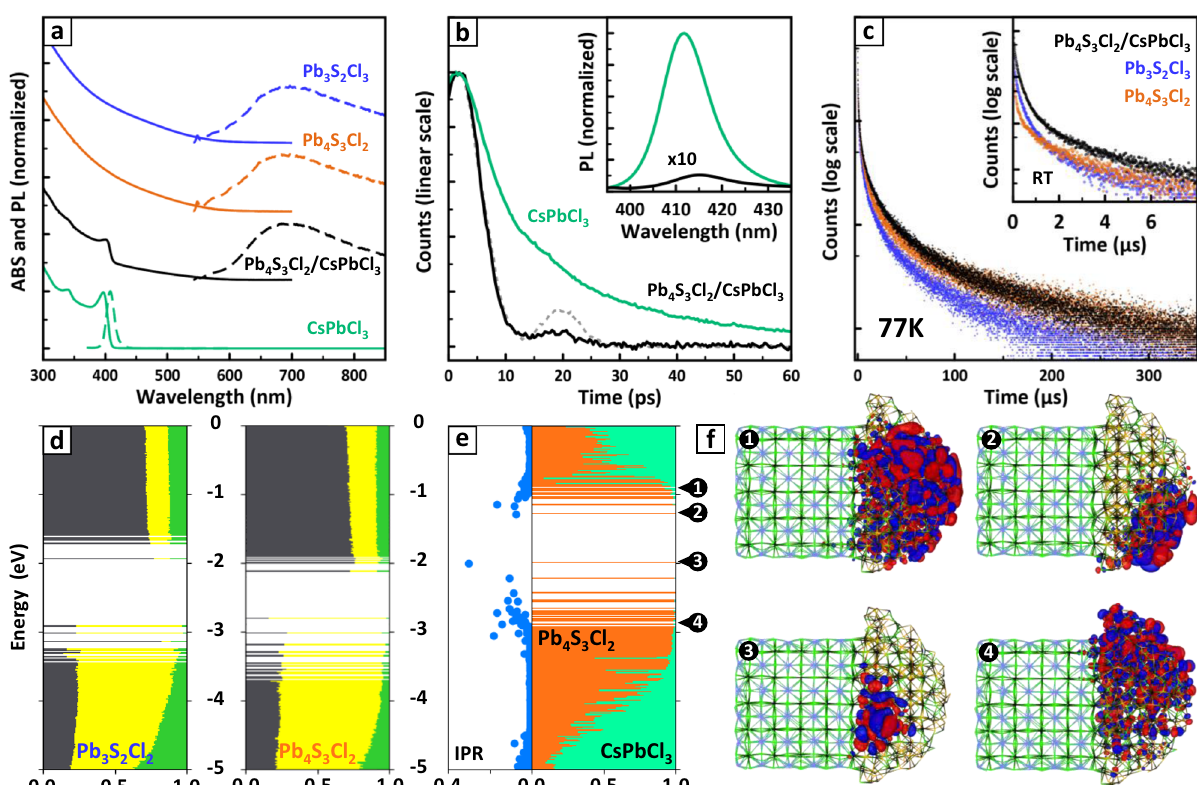
Fig. 5 Optoelectronic properties of lead sulfohalide NCs and Pb 4 S 3 Cl 2 /CsPbCl 3 heterostructures. a Absorption (ABS, solid lines) and photoluminescence (PL, dashed lines) spectra of free-standing Pb 3 S 2 Cl 2 , Pb 4 S 3 Cl 2 , CsPbCl 3 NCs and of Pb 4 S 3 Cl 2 /CsPbCl 3 heterostructures. The CsPbCl 3 NCs were prepared for comparison purposes by heating the CsPbCl 3 precursor nanoclusters (see Supplementary Discussion, section 6). b Decay curves of the ∼ 410 nm PL from CsPbCl 3 as free-standing NCs and in the Pb 4 S 3 Cl 2 /CsPbCl 3 heterostructures. The dashed gray line is the time response of the experimental setup. Inset: PL spectra of CsPbCl 3 as free-standing NCs and in the heterostructures, showing a drastic quenching in the latter case. The PL intensity of the heterostructures is multiplied ×10 to make it more visible. The slight redshift of the heterostructure PL maximum is likely due to the relaxation of quantum con fi nement of the perovskite domain caused by the partial delocalization of the exciton in the chalcohalide domain. c Decay curves of the ∼ 1.8 eV ( ∼ 690 nm) emission of the three samples at room temperature and at 77 K (inset). Color code for a – c : cyan = CsPbCl 3 , blue = Pb 4 S 3 Cl 2 , orange = Pb 3 S 2 Cl 2 , black = Pb 4 S 3 Cl 2 /CsPbCl 3 heterostructures. d Electronic structure of free-standing Pb 3 S 2 Cl 2 (left) and Pb 4 S 3 Cl 2 (right) NC models computed at the DFT/PBE level of theory. The color code indicates the elemental contribution to each molecular orbital (Pb = gray; S = yellow; Cl = green). e Electronic structure of the Pb 4 S 3 Cl 2 /CsPbCl 3 heterostructure model computed at the DFT/PBE level of theory, color coded by domain (Pb 4 S 3 Cl 2 = orange; CsPbCl 3 = cyan). The Inverse Participation Ratio (IPR, left panel) quanti fi es the degree of localization of a state (1/ N atoms = completely delocalized; 1 = localized on one single atom), and indicates that most of the states surrounding the band gap are localized trap states. f Representation of molecular orbitals corresponding to band edge delocalized states (1,4) and to band edge trap states (2,3). In both cases, the band edge states are localized on the Pb 4 S 3 Cl 2 domain. Source data for a – e are provided as a Source Data fi